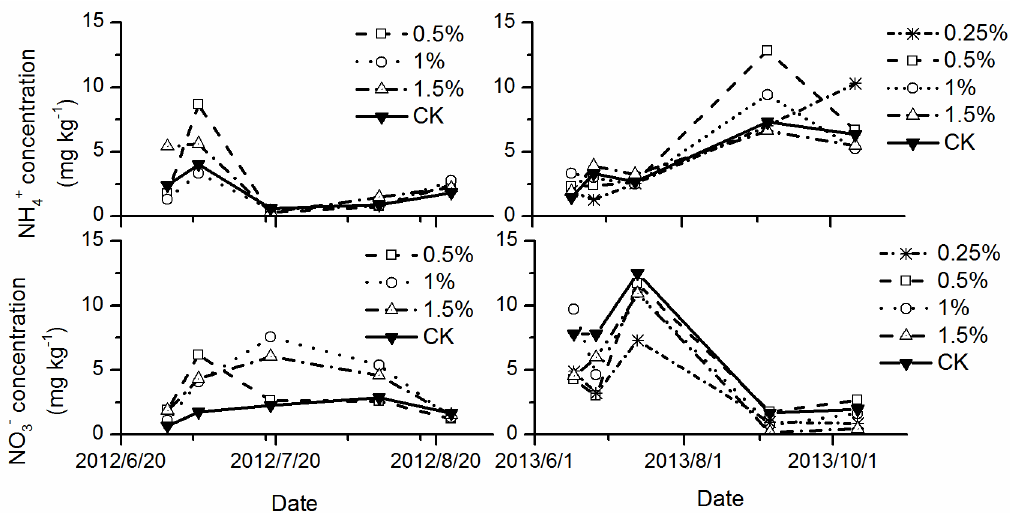
Figure 3. Variation of soil inorganic N concentration under different DMPP treatments.